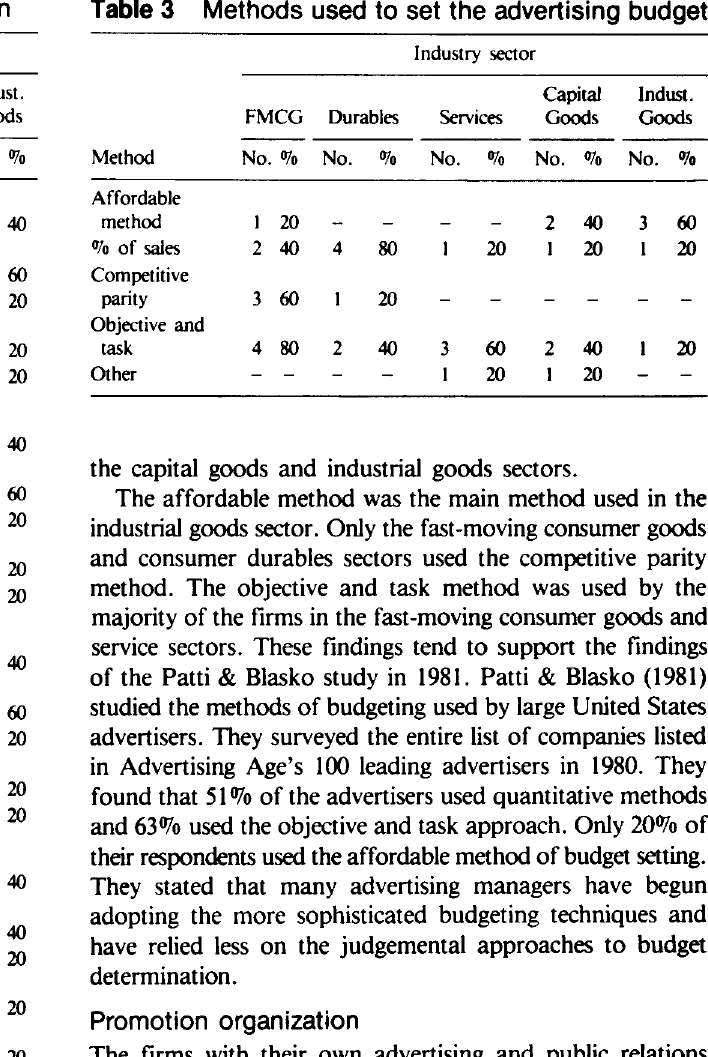
Methods used to set the advertising